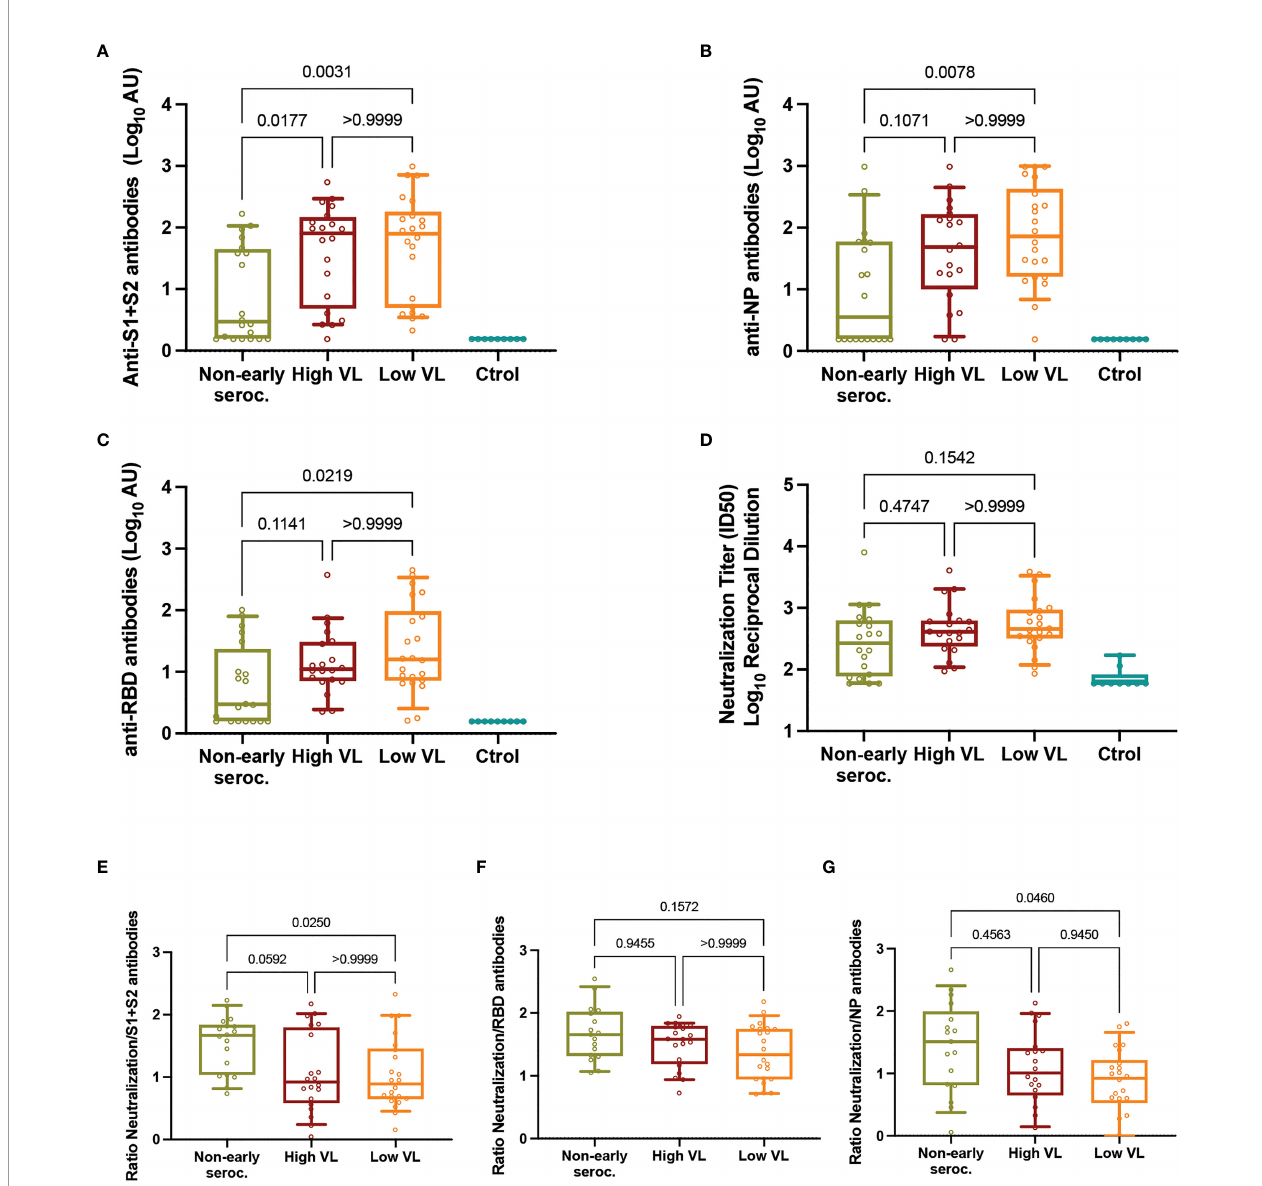
FIGURE 2 | Neutralizing activity. Individual titers of (A) anti-S1+S2 antibodies, (B) anti-NP antibodies, (C) anti-RBD antibodies, and (D) neutralization. Individual ratios of neutralization titers to (E) anti-S1+S2, (F) anti-RBD, and (G) anti-NP antibodies. In all panels, boxes show the median and the 25 th -75 th interquartile range and bars the 10 th -90 th interquartile range. P values correspond to Kruskal-Wallis test with Dunn ’ s multiple comparisons. ID, inhibitory dilution; NP, nucleocapsid protein; VL, viral